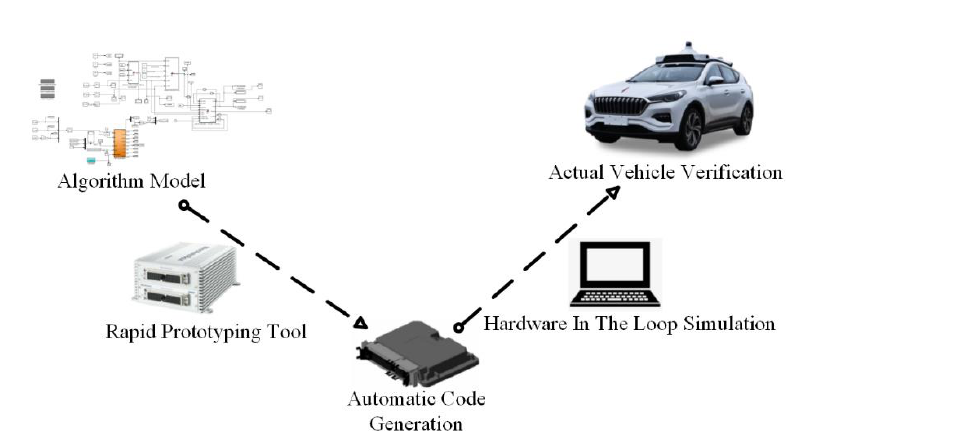
Figure 11. Rapid prototyping approach.